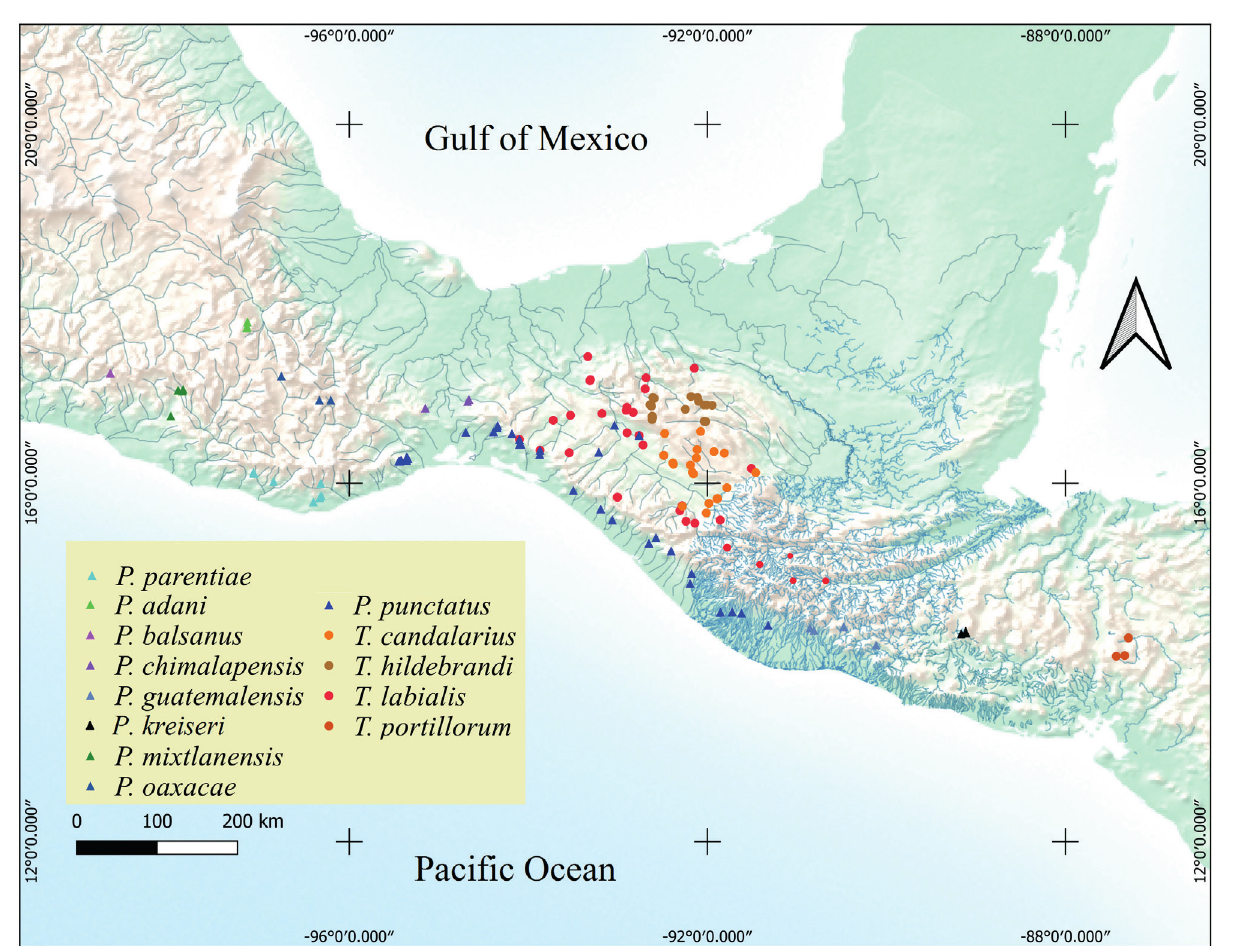
FIGURE 8 | Geographical distribution of species of the genera Tlaloc and Profundulus in southern Mexico and Central